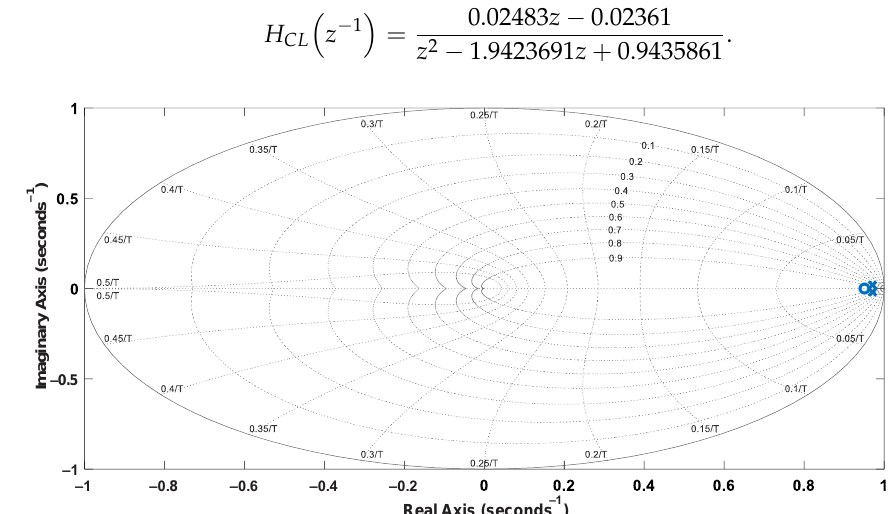
Figure 11. Pole-zero map of the discretized closed-loop model.